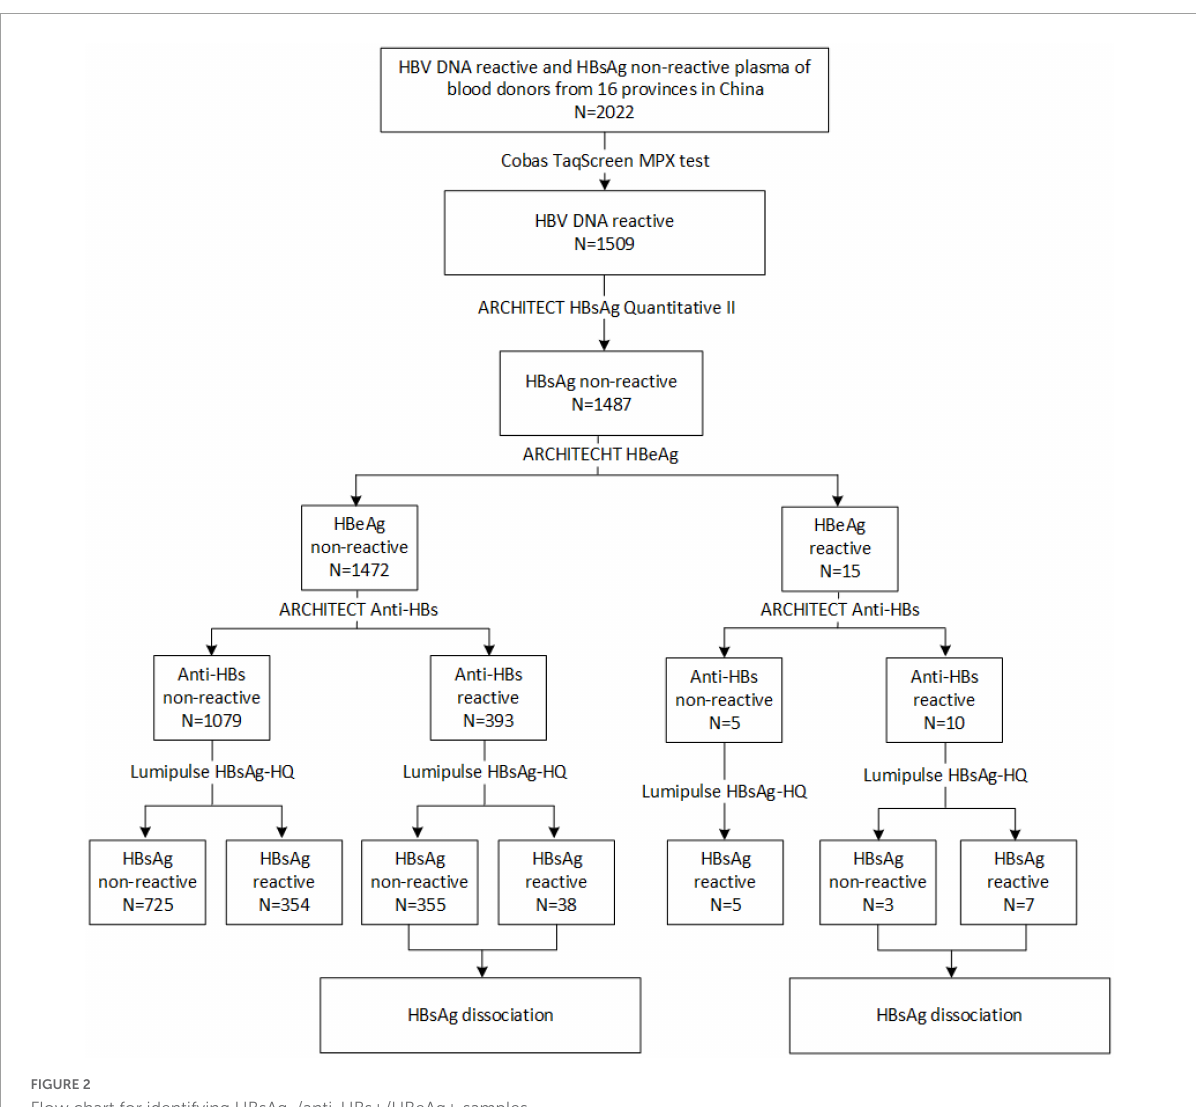
FIGURE2 Flow chart for identifying HBsAg-/anti-HBs+/HBeAg+ samples.